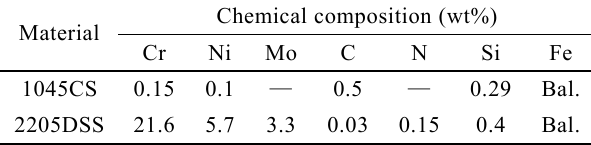
Table 1 Chemical compositions of AISI 1045 and AISI 2205.